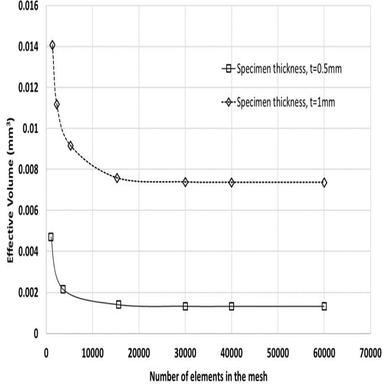
Effect of the element size in the calculated effective volume. Values of Young´s modulus, E = 200 GPa, Poisson´s coefficient, ν = 0.3 and Weibull modulus, m= 10 were used for the FEM calculations.